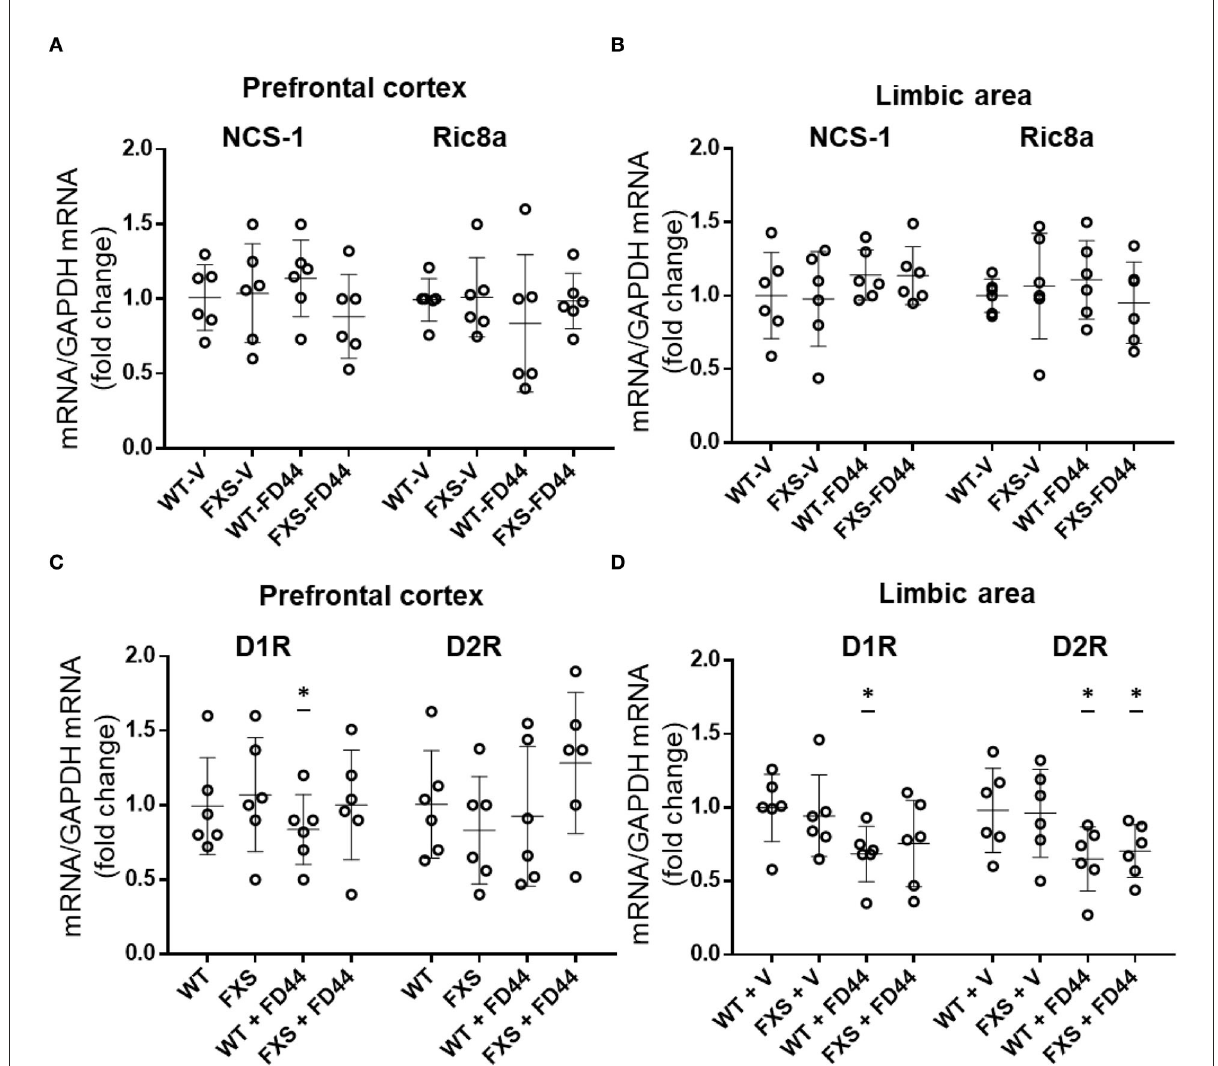
FIGURE6 Expression profile of NCS-1, Ric8a, and DA receptors D1 and D2. Ribonucleic acid (RNA) from the limbic system and prefrontal cortex of Fmr1 KO (FXS) or WT mice was extracted after treatment with V or with FD44 intraperitoneally for 4 weeks, and qRT-PCR was performed. (A) The messenger RNA (mRNA) levels of NCS-1 and Ric8a normalized with glyceraldehyde 3-phosphate dehydrogenase (GAPDH) mRNA are shown in the prefrontal cortex or (B) limbic area. (C) The mRNA levels of DA receptor D1R and D2R normalized with GAPDH mRNA are shown in the prefrontal cortex or (D) limbic area. Data were analyzed by one-way ANOVA followed by Bonferroni multiple pair-wise comparison. Scatter plots show mean ± SD of six mice per condition measured in triplicates. Comparisons are performed with WT-V because it is considered the basal expression condition, and the fold change is represented in the graph. * p < 0.05 is considered significant; otherwise it is